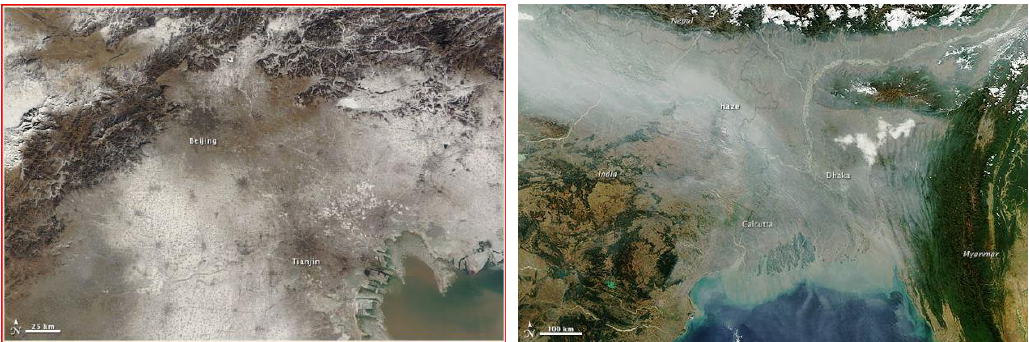
Figure 6: Satellite Image of smog in China, found in Google Image search for smog in Tehran Figure 7: Satellite Image of smog over Calcutta, found in Google Image search for smog in